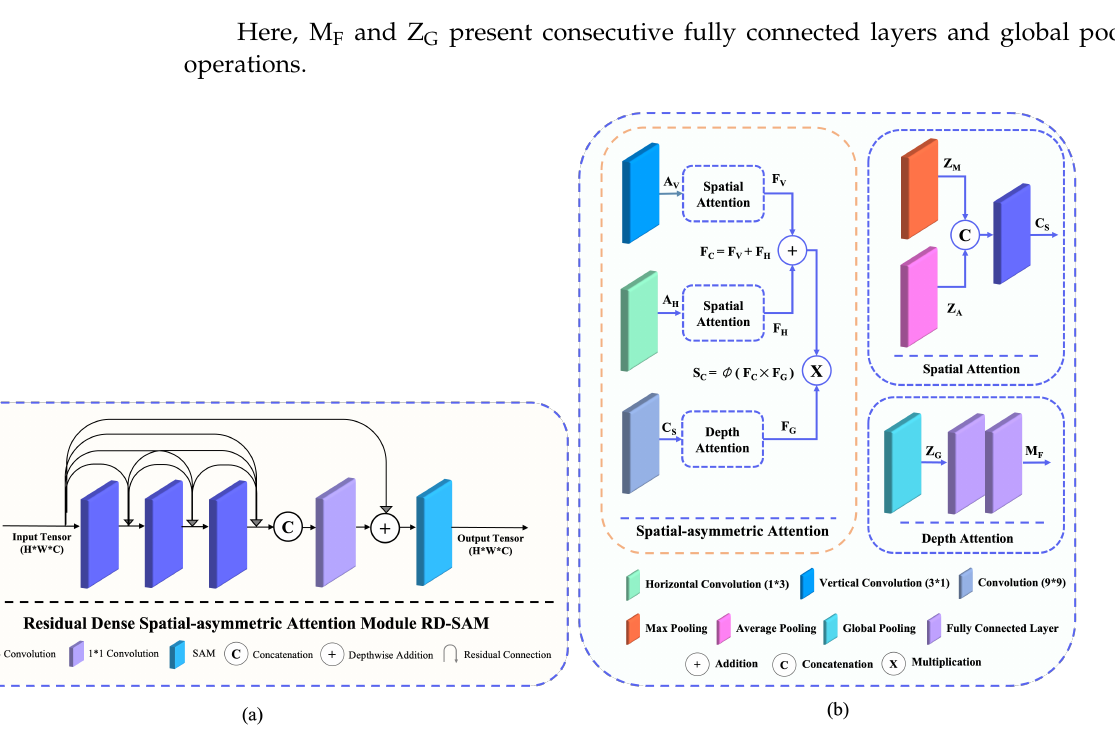
Figure 3. Overview of proposed RD-SAM. It comprises a residual dense block, followed by a spatial- symmetric attention module. ( a ) Proposed RD-SAM. ( b ) Spatial-asymmetric attention